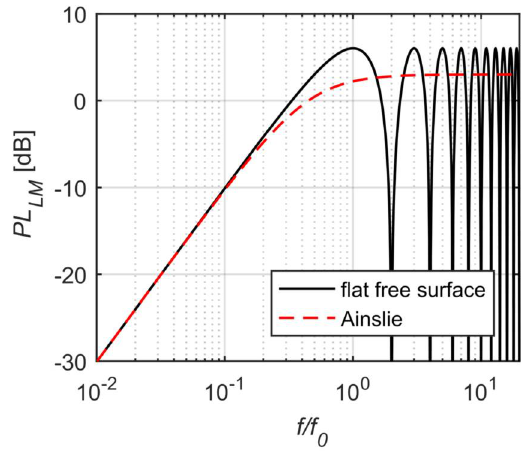
Figure 10. Propagation loss due to the Lloyd’s mirror effect.